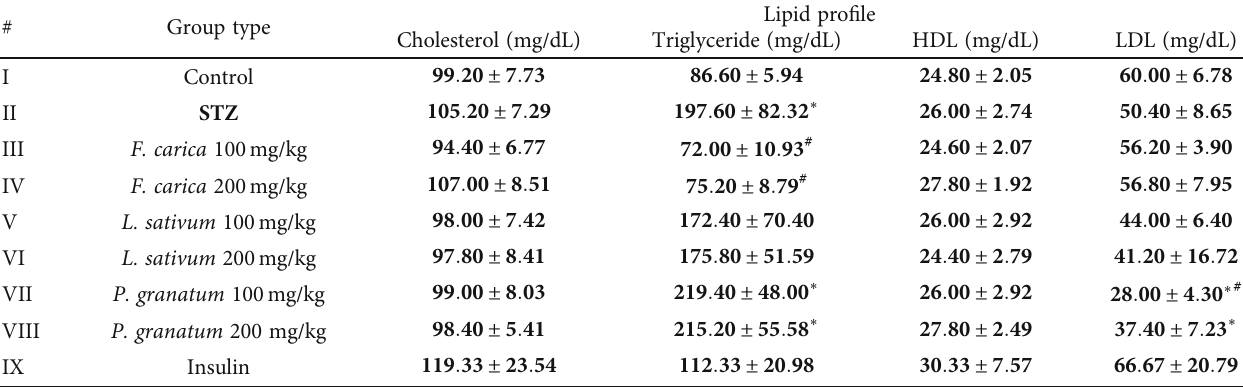
Table 4: E ff ect of di ff erent Lepidium sativum , Ficus carica , and Punica granatum methanolic extracts on serum cholesterol, triglycerides, cholesterol high-density lipoprotein (HDL), and cholesterol low-density lipoprotein (LDL) in STZ-induced diabetic rats after 5